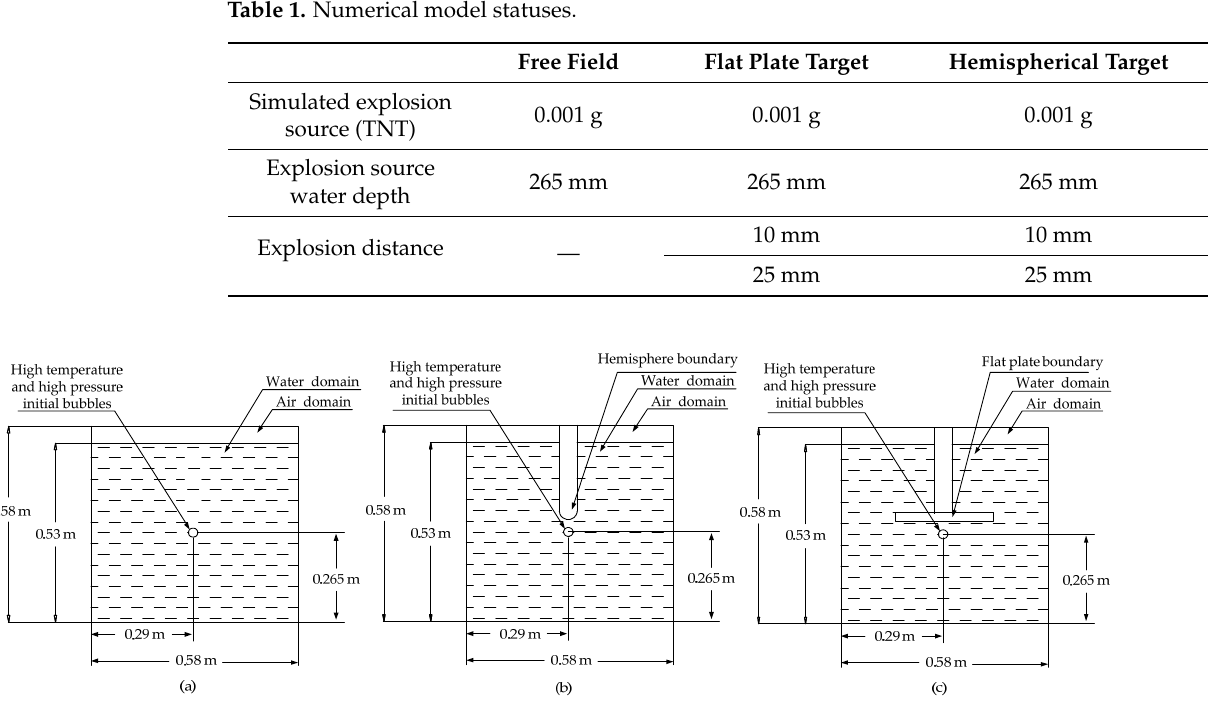
Figure 4. The arrangement of the model: ( a ) Free field; ( b ) hemisphere target; ( c ) flat plate target. In the numerical simulation, the settings of the water depth, the position of the surface boundary, and the initial position of the bubble were the same as in the real